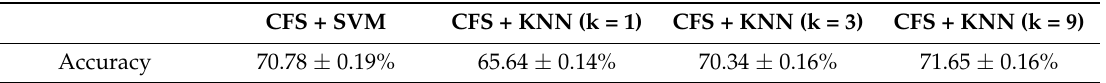
Table 6. Feature selector and